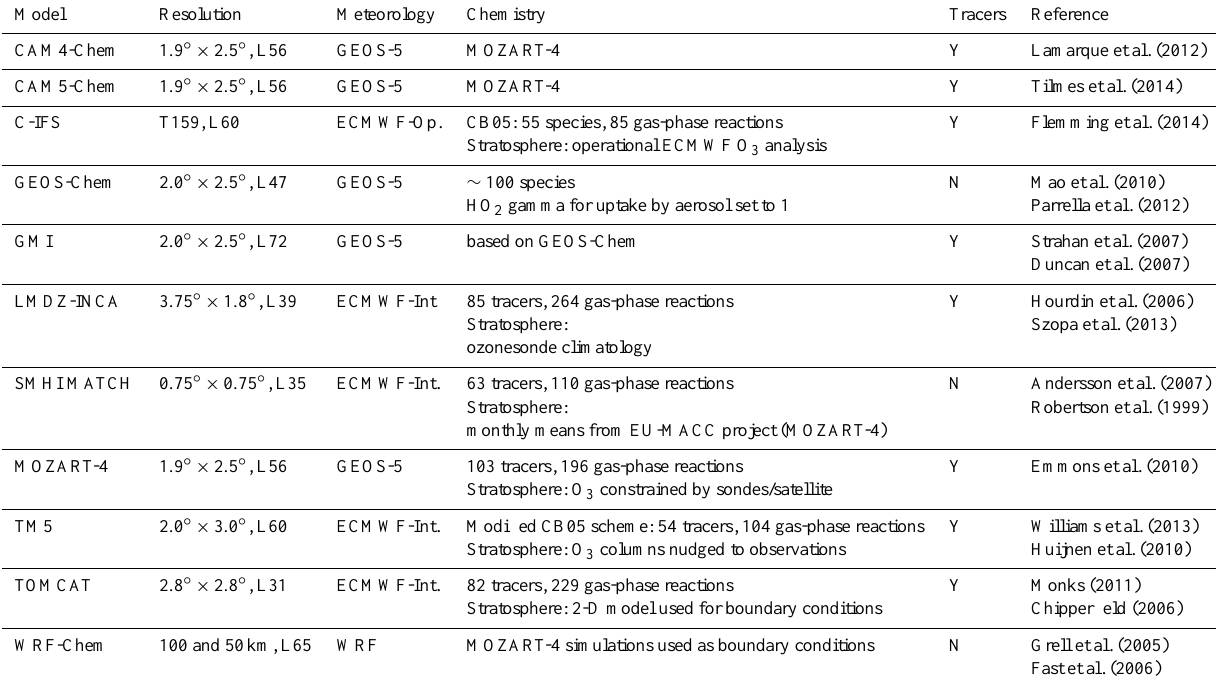
Table 1. Participating models in the inter-comparison. Y in the tracers column indicates that idealised tracers from that model have been used for the transport and chemistry analysis in Sect. 5, Figs. 14-17. (N.B. MATCH provided the 25-day tracers for inclusion in Fig. 13; however, they were excluded from the analysis in Figs. 14–17 as the regional model OH field could not be used in the global TOMCAT model to calculate the OH tracers needed to perform the statistical